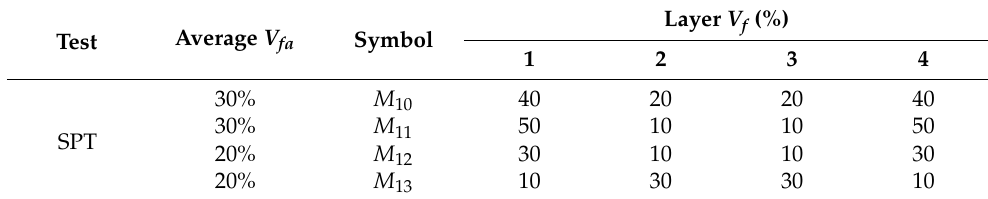
Table 3. The layers’ V f values for the different specimens with average V fa .